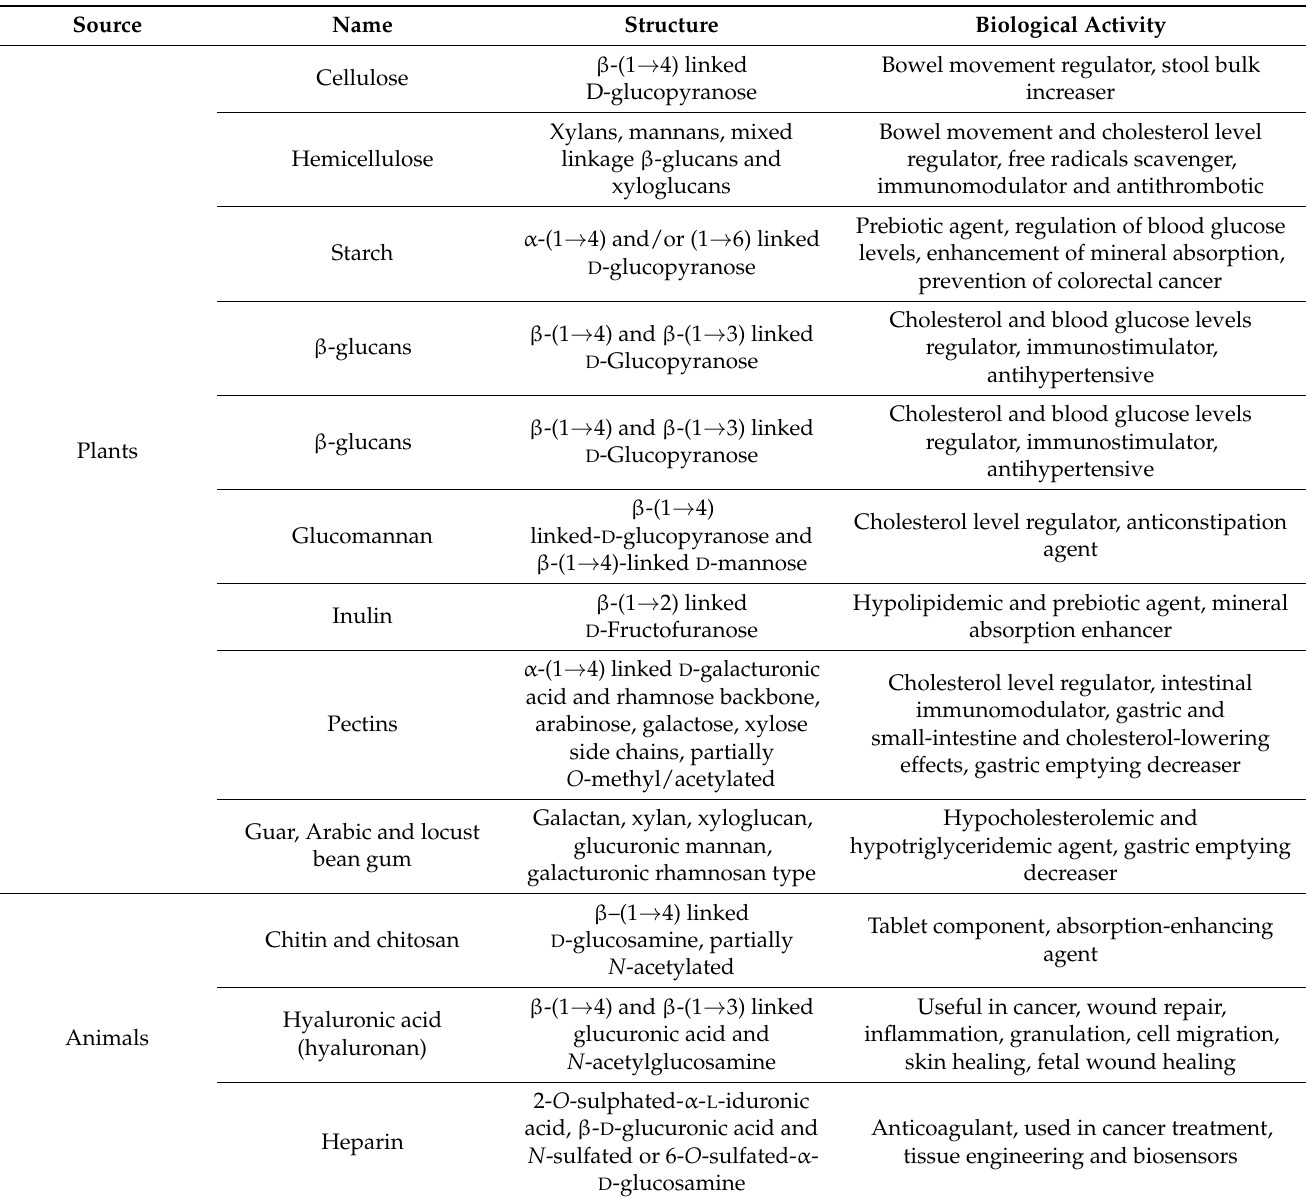
Table 1. List of polymeric biomaterials related to their sources and